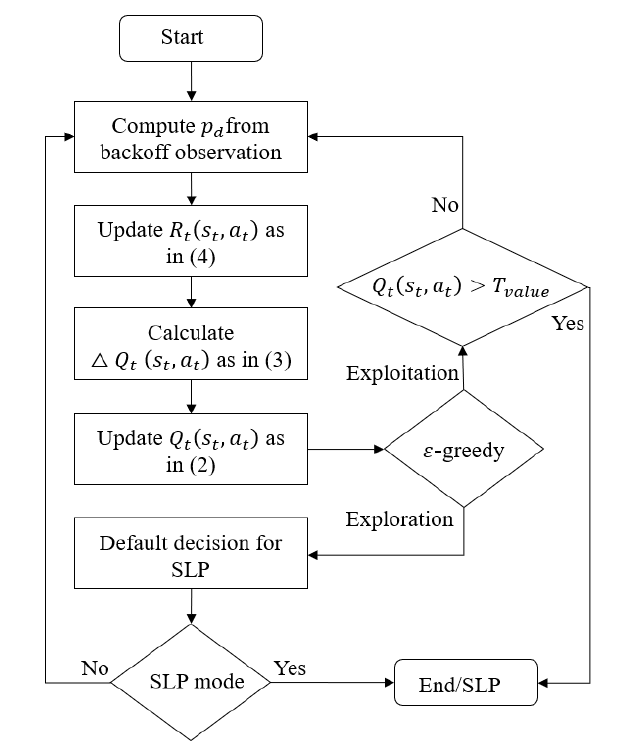
Figure 3. Flowchart to describe functionalities of green MAC